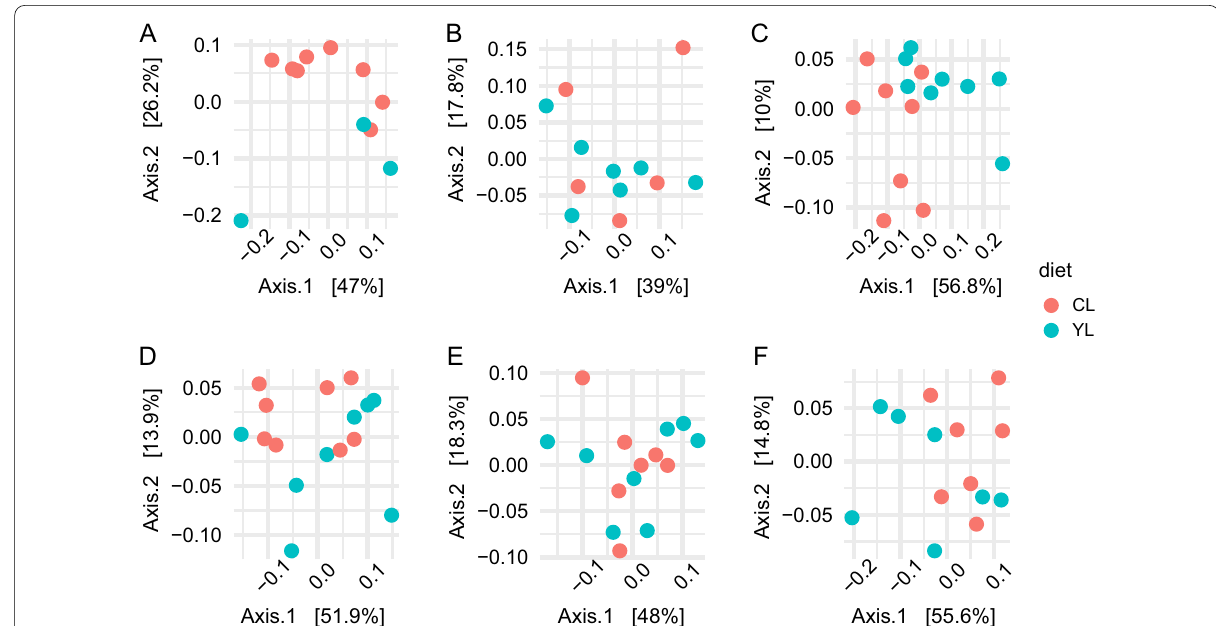
Fig. 3 Beta microbial diversity. Principal coordinate analysis on weighted UniFrac distances of the faecal microbiomes coloured by diet at day 0 ( A ), 8 ( B ), 22 ( C ), 36 ( D ), 57 ( E ), and 87 ( F )